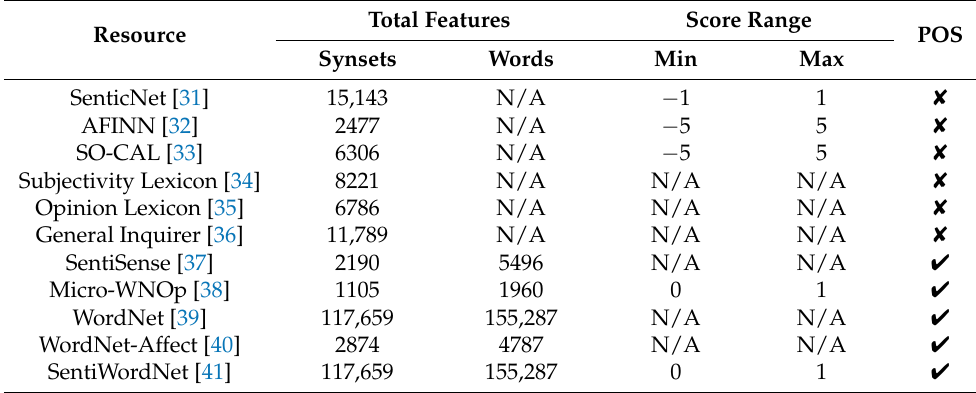
Table 1. A summary of lexical resources.